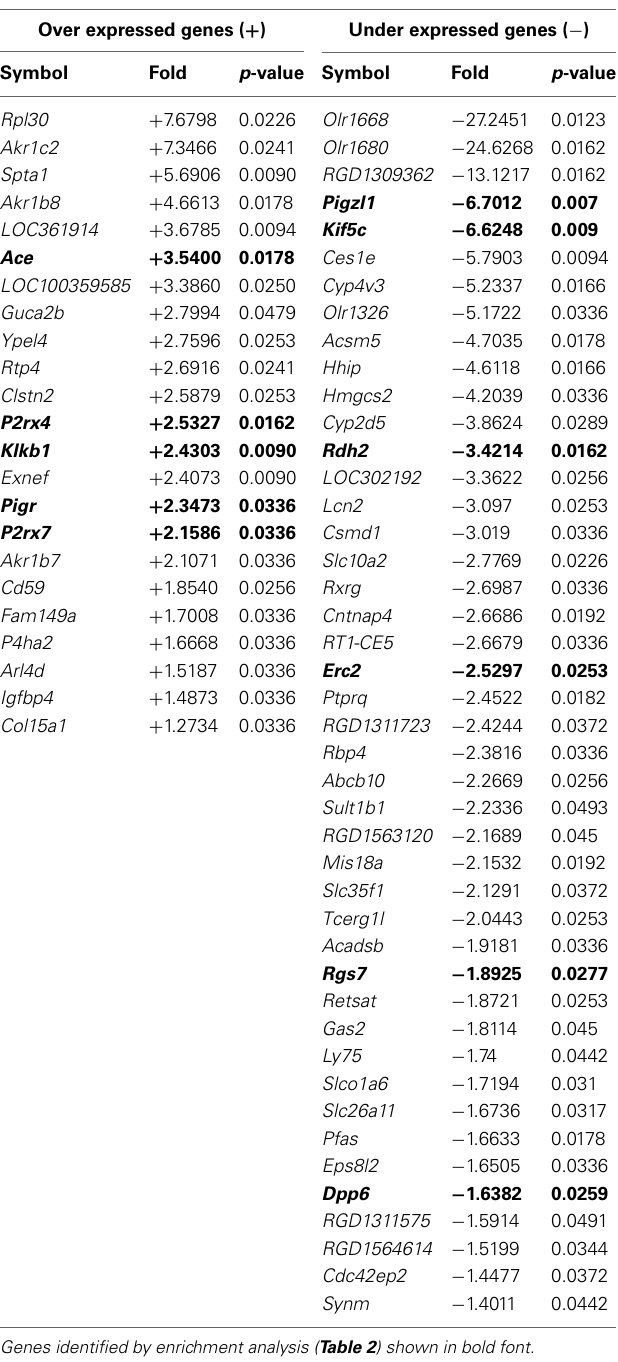
Table 1 | Genome wide comparison of gene expression between F344 and Lewis inbred strains listed in order of magnitude of fold change (F344 vs. Lewis, fold > ± 1.2, p < 0 .